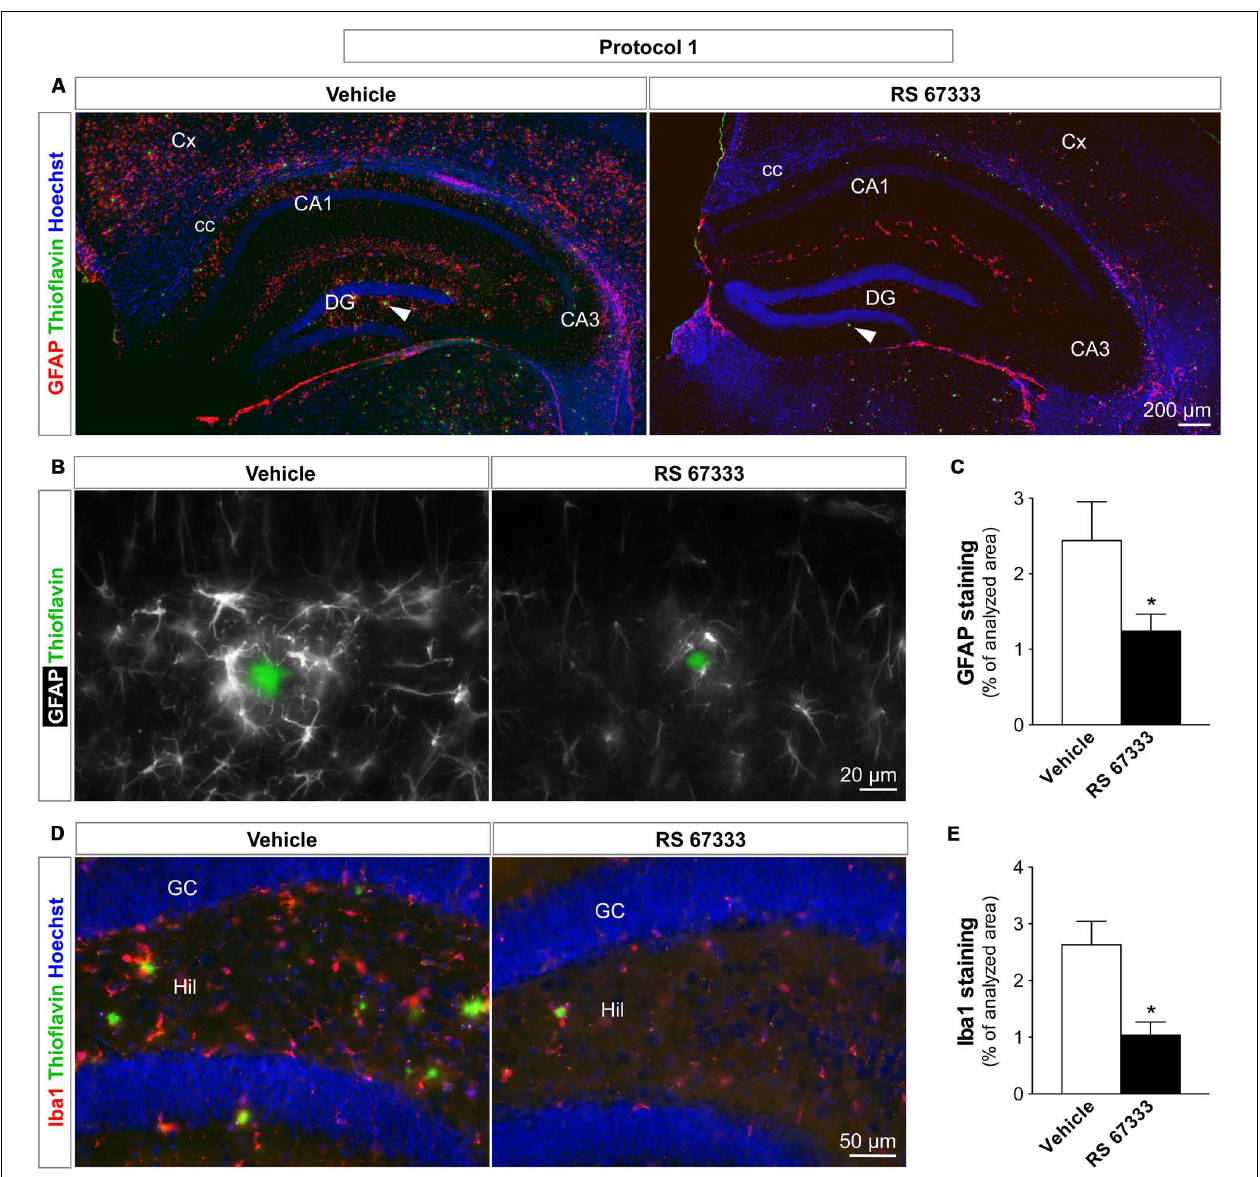
magnifications (40 × objective) of distinct plaques indicated by white arrowheads in (A) . Quantification of GFAP (C) and IBA1 (E) staining, markers of astroglia and microglia, respectively. Data are presented as the mean ± SEM. ∗ p < 0.05 compared with vehicle